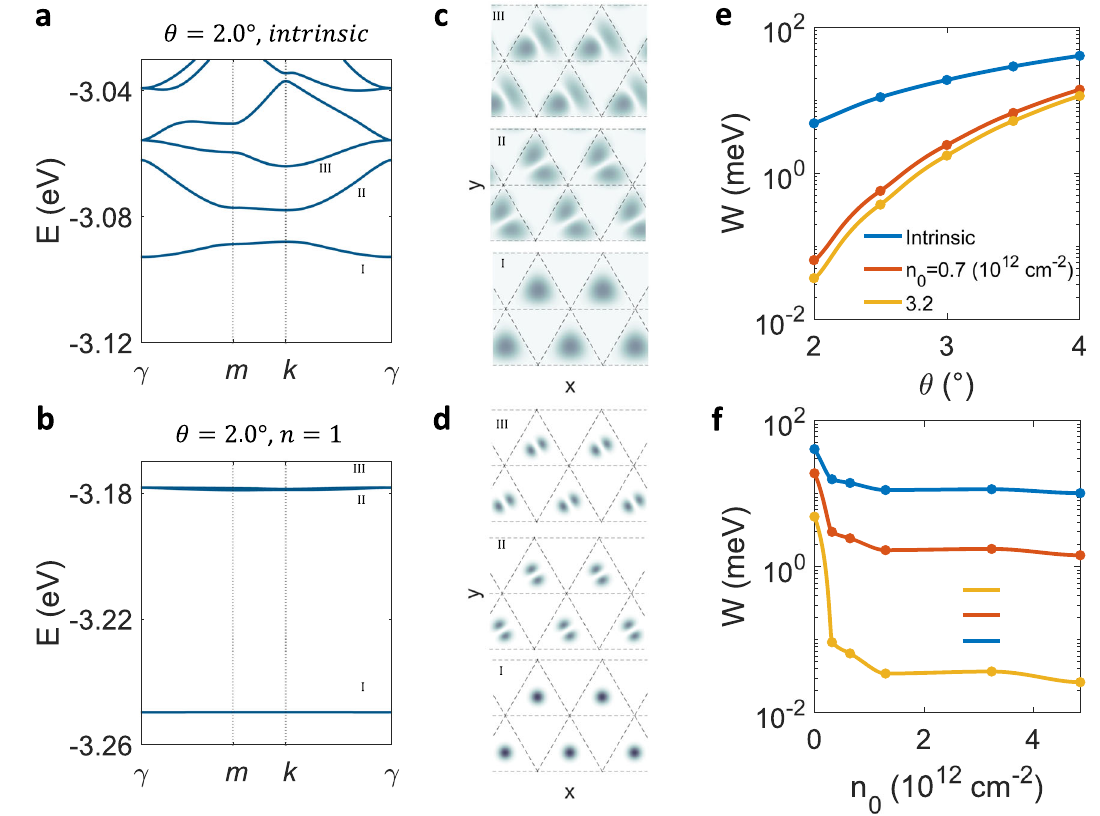
Fig. 3 Isolated ultra- fl at bands in a doped moiré system. Low-energy moiré QP band structure of 2° twisted MoS 2 /WS 2 a intrinsic structure, b doped with n = 1 electron per moiré superlattice. c , d Real-space wavefunctions associated with the three lowest conduction bands I, II, and III shown in ( a , b ), respectively. e Variation of bandwidth in terms of the twist angle. f Variation of bandwidth in terms of the average doping density. The vertical axes in ( c , f ) are shown in the log scale for